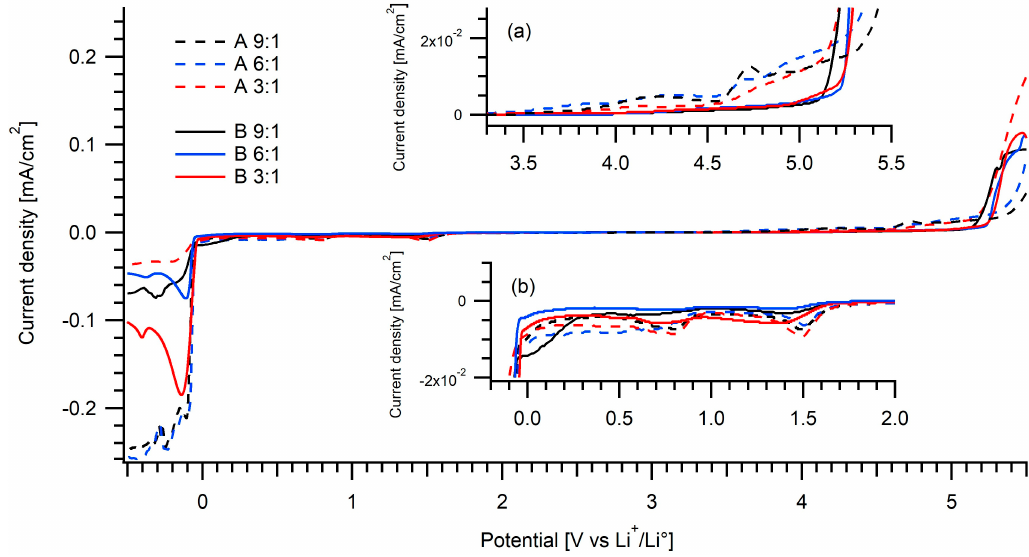
Figure 5. LSV at 1 mV/s scan rate, with insets for the anodic ( a ) and cathodic ( b )